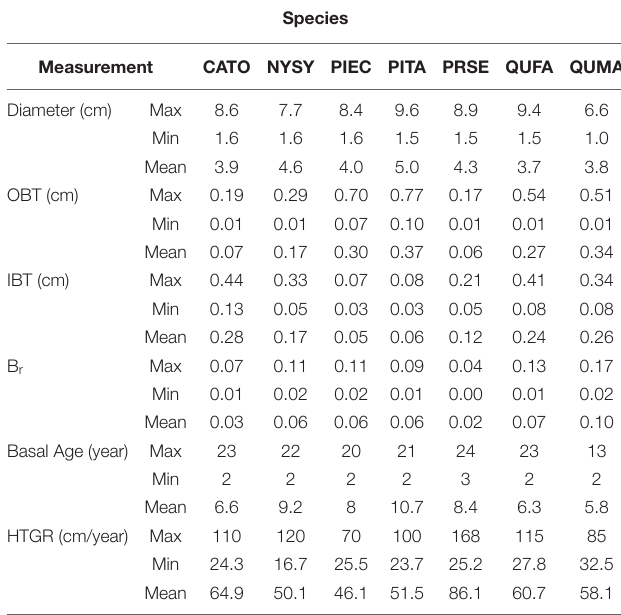
TABLE 1 | Summary statistics for basal cross-sections of seven co-occurring species in the Tallahatchie Experimental Forest,